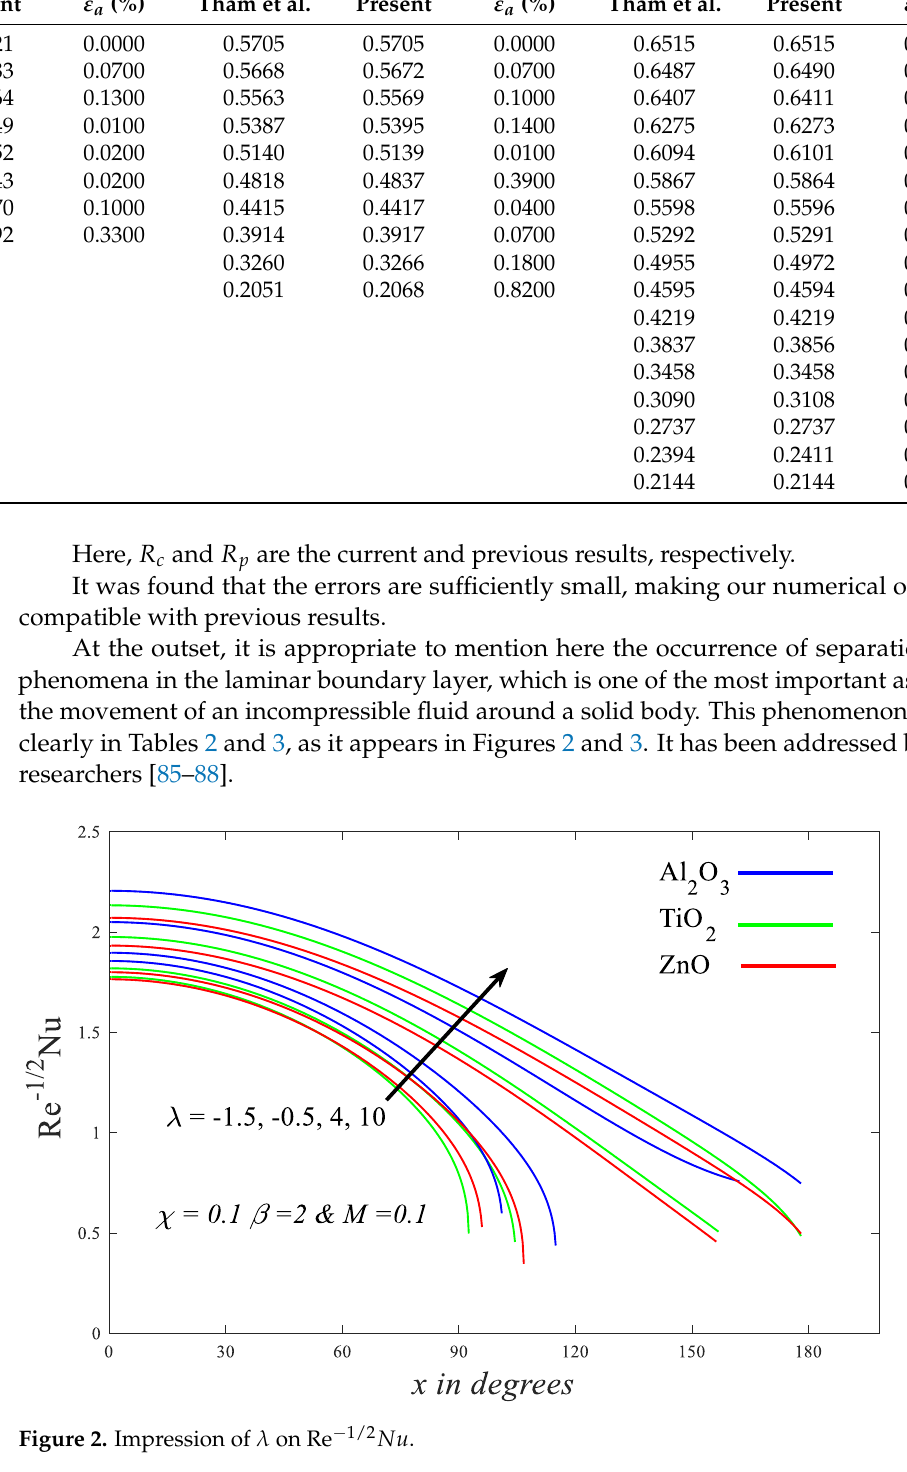
Figure 2. Impression of λ on Re − 1/2 Nu